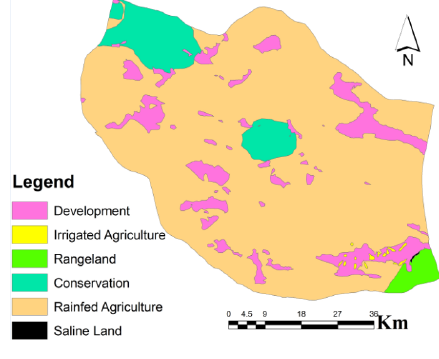
Figure 6: Land use planning